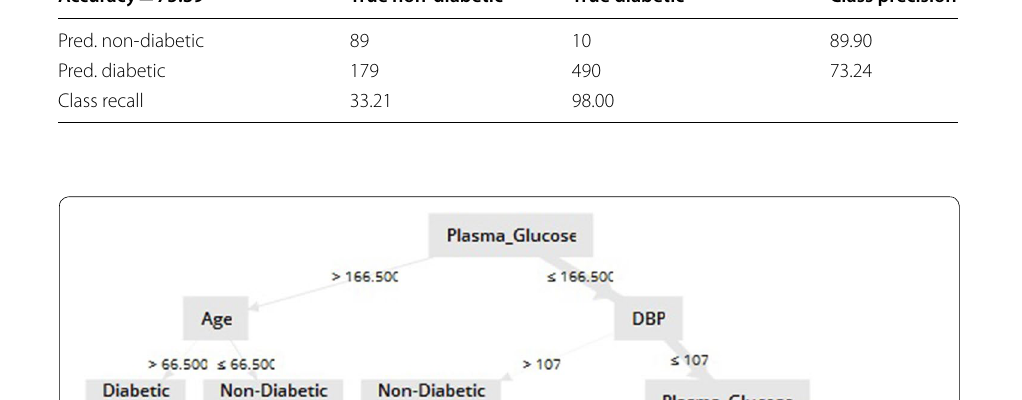
Table 4 Results of random forest Accuracy 75.39 =